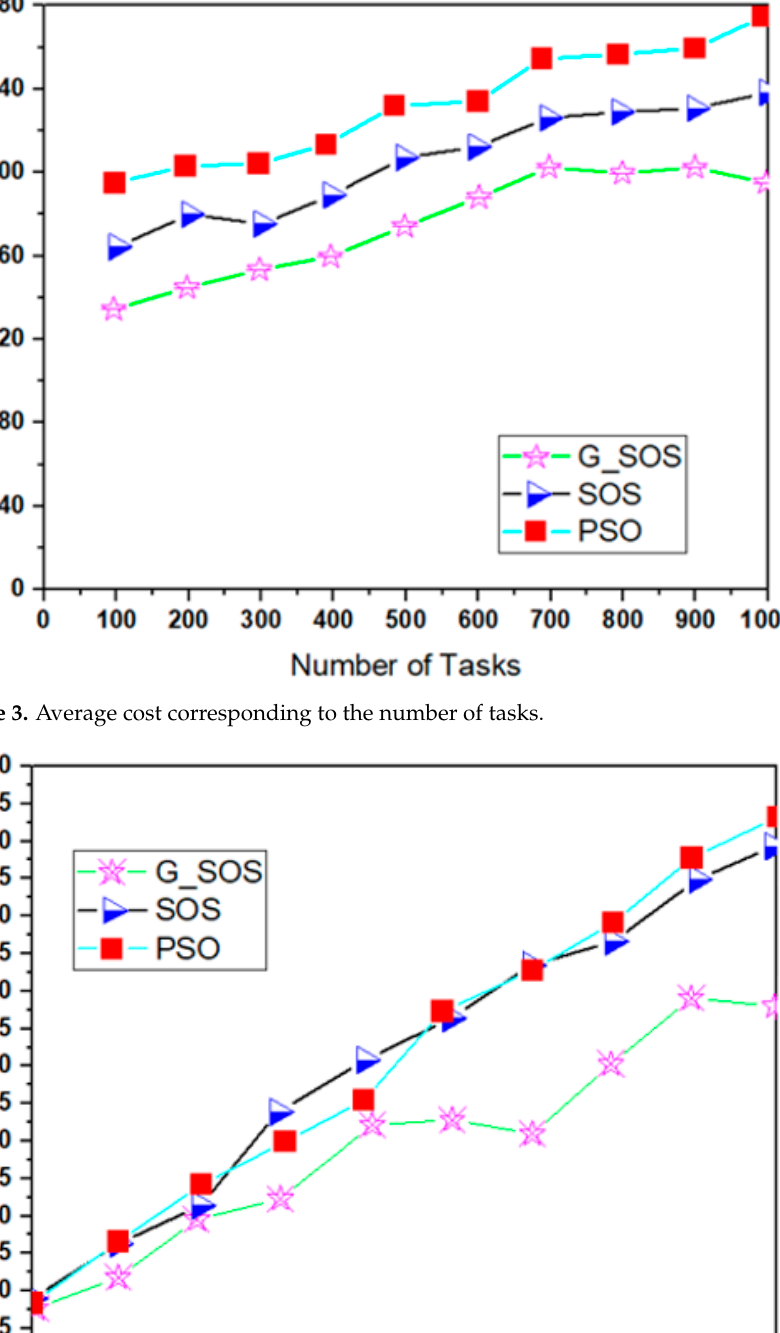
Figure 2. Makespan comparison between G_SOS, SOS and PSO (uniform distribution).